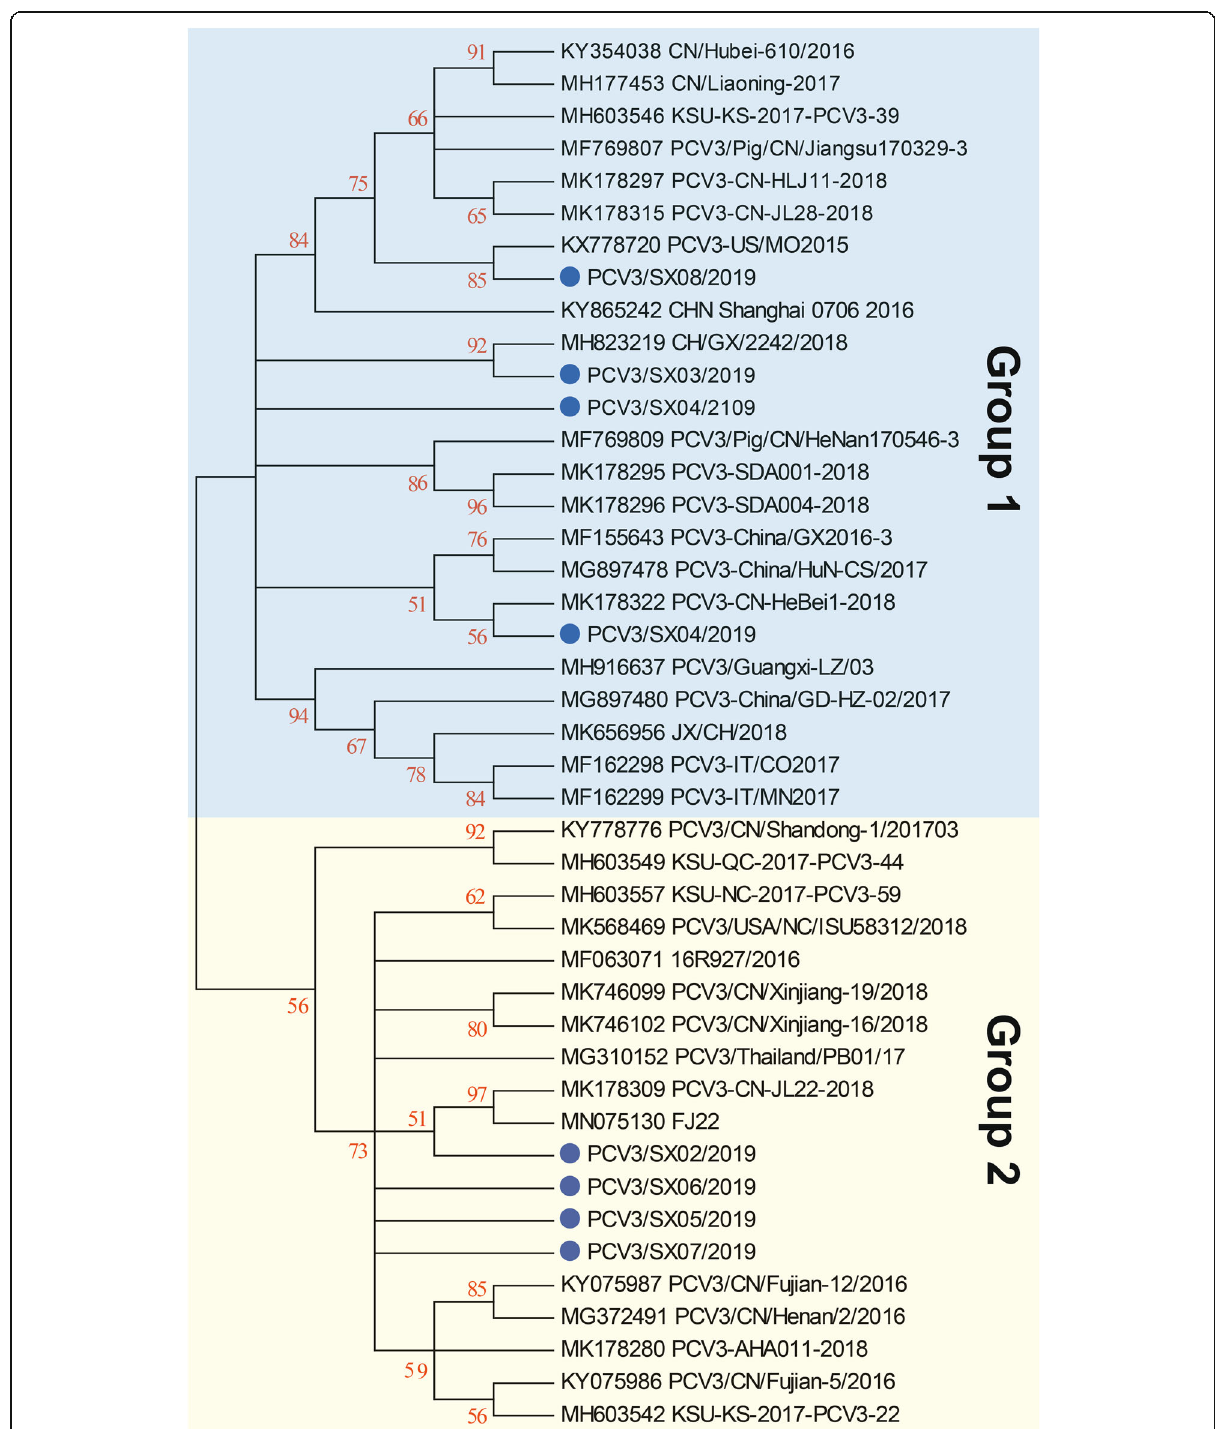
Fig. 2 Phylogenetic tree of the complete sequences of porcine circovirus type 3 (PCV3). Blue dots indicate PCV3 strains investigated in this